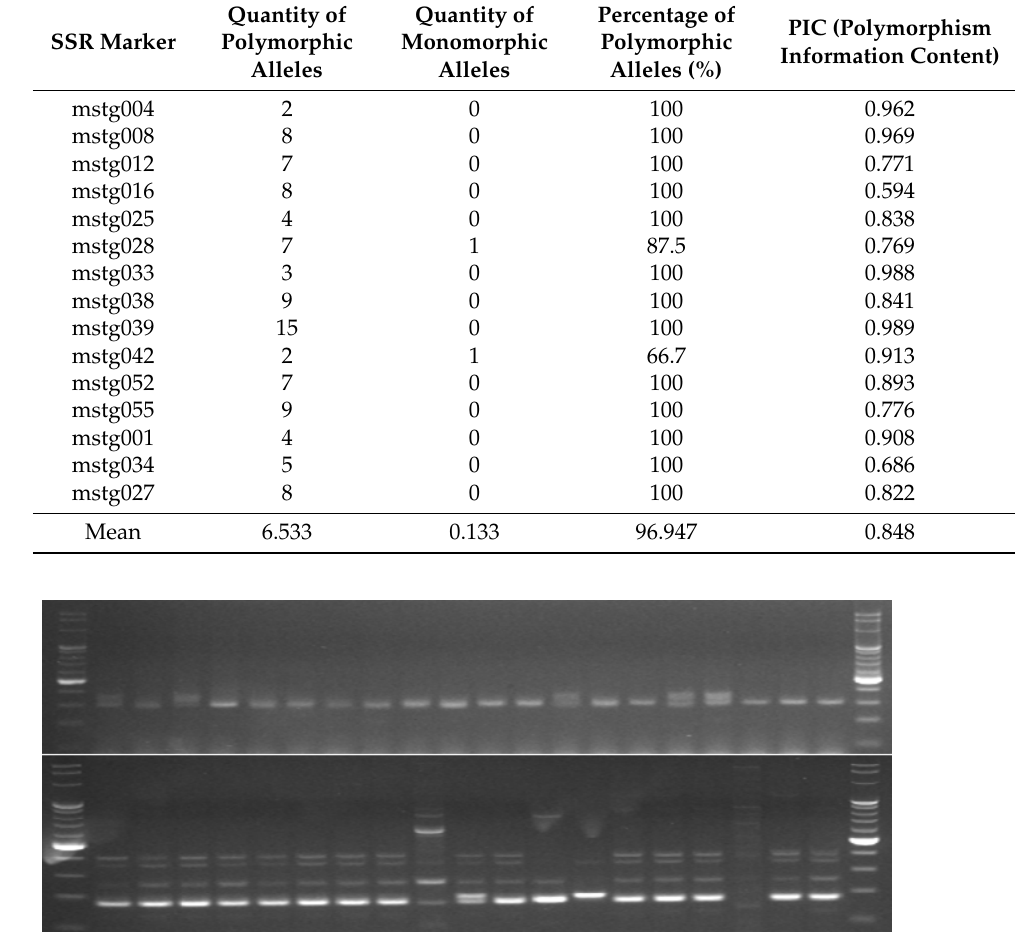
Figure 1. Example of electrophorograms with visible PCR products. Results for genotypes 21–40, marker mstg004 ( above ) and mstg008 ( below ).